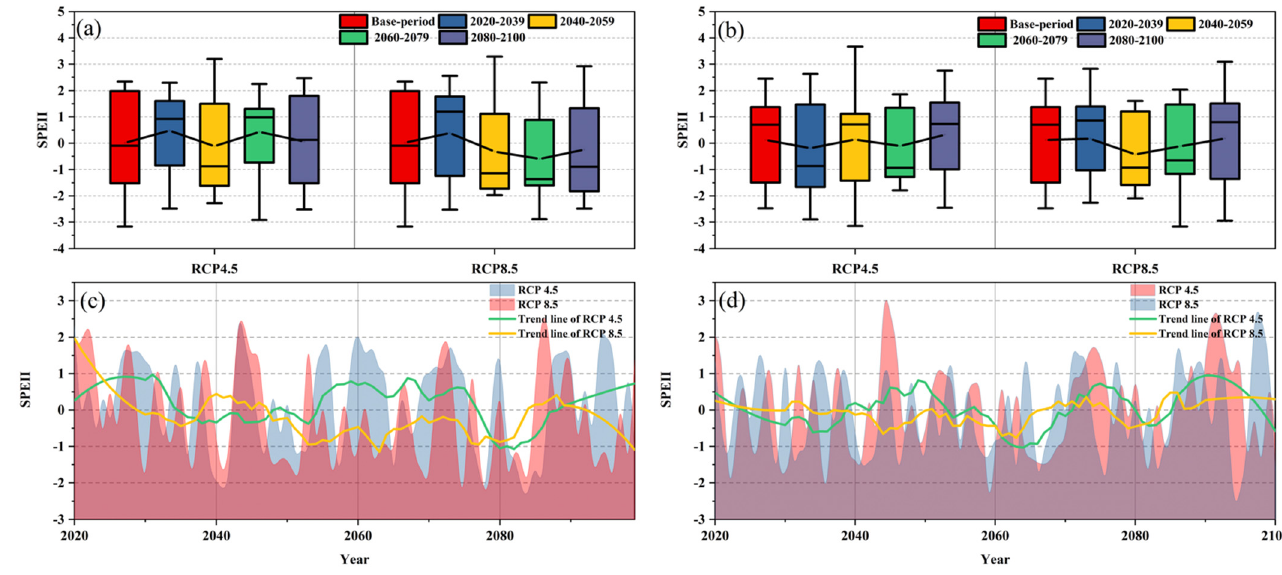
Figure 9. Drought change in winter wheat ( a ) and summer maize ( b ) in the growth period of different periods under the RCP4.5 and RCP8.5 scenarios in typical crop-producing areas. Drought change trend of winter wheat ( c ) and summer maize ( d ) in the growth period under the RCP4.5 and RCP8.5 scenarios in typical crop-producing areas.